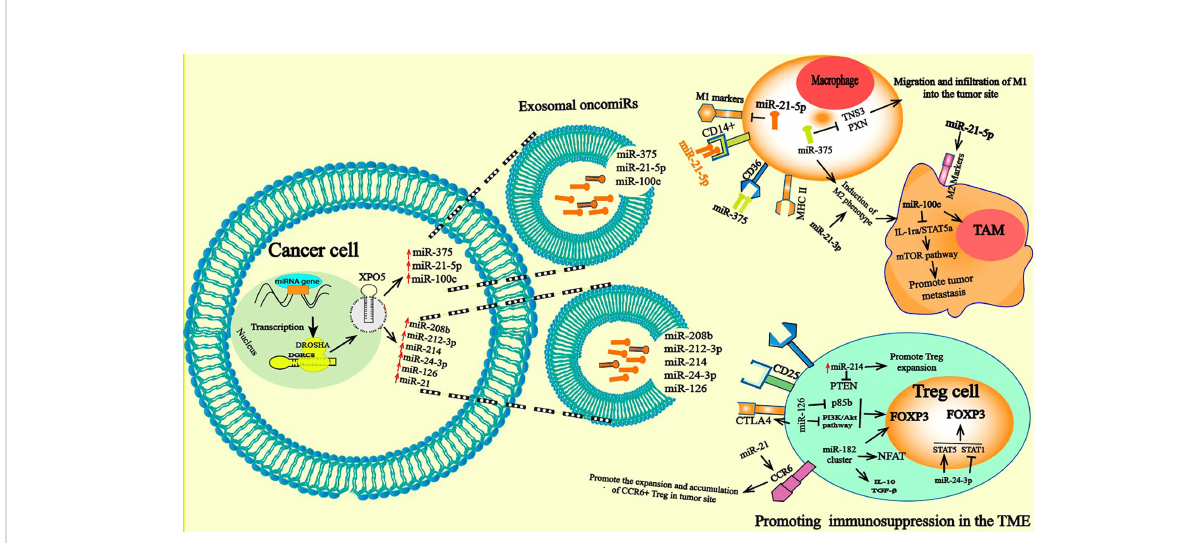
FIGURE 3 Pro-tumorigenic functions of TAM and Treg cells: miRNAs delivered by tumor derived exosome induce abnormally expressed miRNA in TAM and Treg. In macrophage, exosomal secreted miRNAs can be taken up by the receptor CD36 and CD14. The aberrantly expressed miRNAs in macrophage can directly induce a change in gene expression and consequently polarizes them toward a protumoral phenotype M2 with anti- in fl ammatory and immunosuppressive proper. A variety of functions of TAM related to cancer progression were descripted; they contribute to tumor cell escape and hinder the antitumor immune mechanism and response through mechanisms such as stimulating angiogenesis, enhancing tumor migration and suppressing antitumor immunity. Treg cells in turn are involved in tumor development and progression by inhibiting antitumor immunity, thereby, facilitating the development of an immunosuppressive TME and promoting cancer progression. The high expression of oncomiRs such onco-miR-182 cluster (miR-96, -182, and -183), miR-126 increased FOXP3, TGF- b , and IL-17 expression and drive polarization of T cells toward the transitional state of IL-17 – producing Tregs and elevated frequencies of Tregs leading to further immune suppression by the potent regulatory/suppressive capacities of